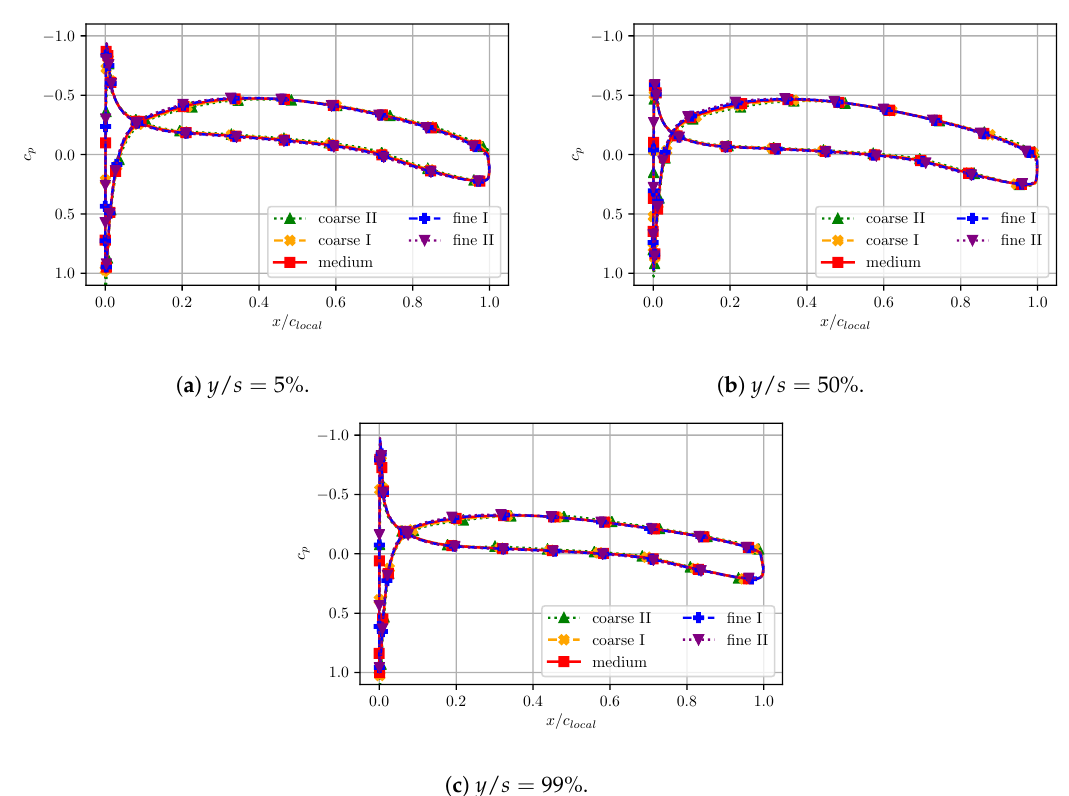
Figure 12. Comparison of chordwise c p -distributions for different grid resolutions of the